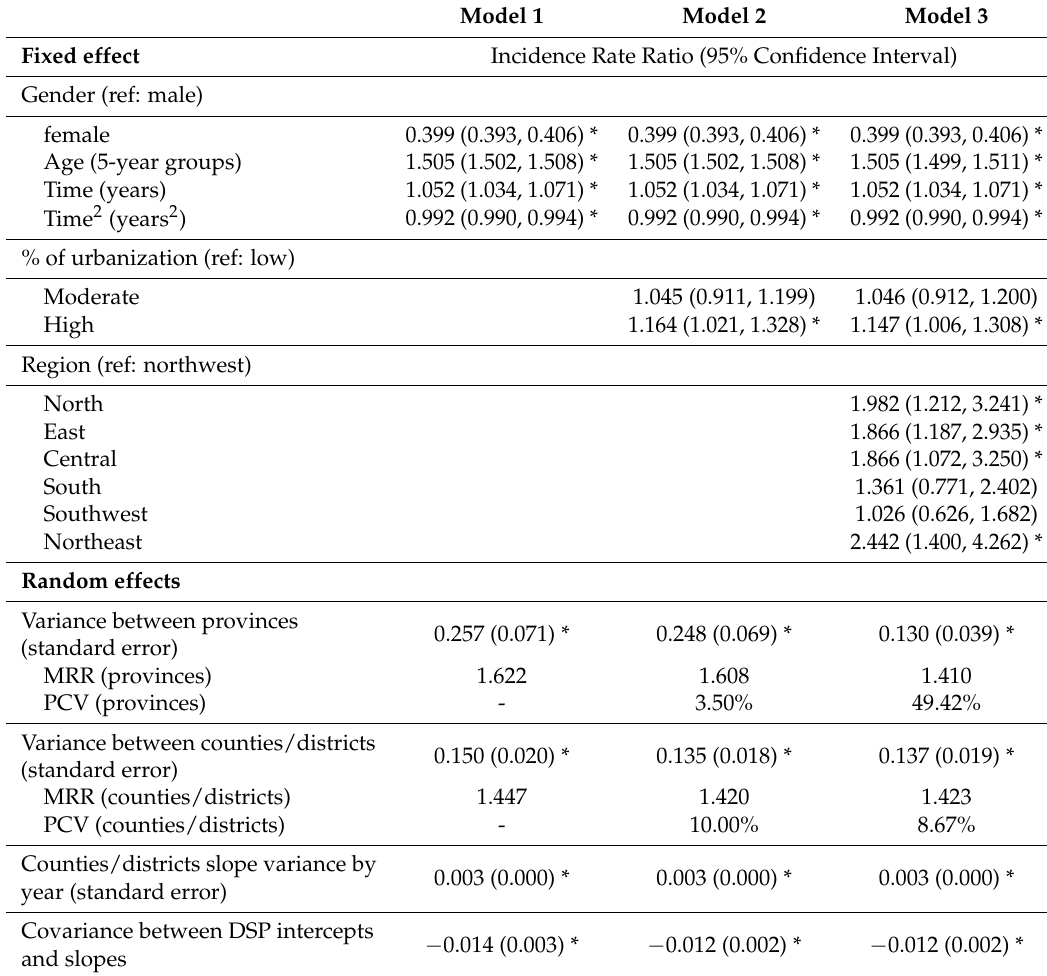
Table 1. Incidence rate ratios and 95% confidence intervals for lung cancer mortality in China between 2006 and 2012